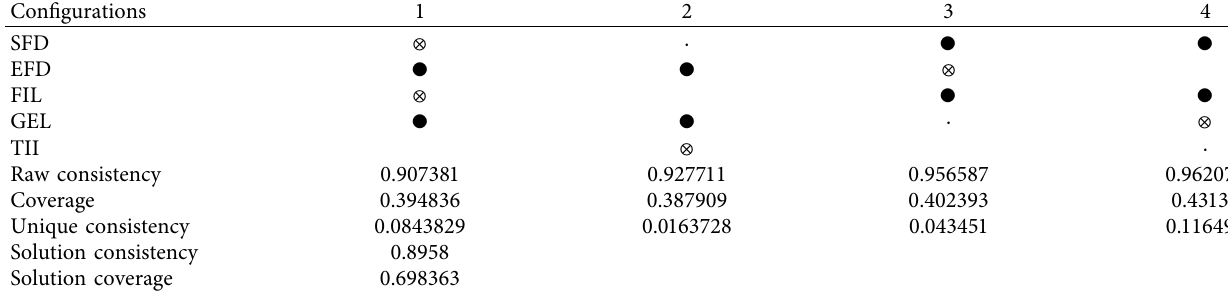
Table 6: Configuration results of higher total factor productivity.